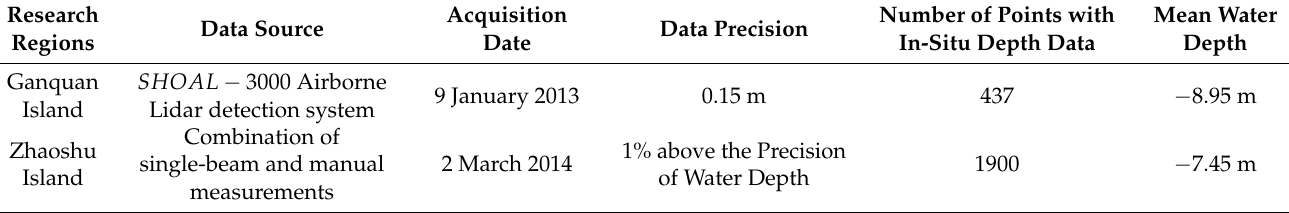
Table 2. Information on the actual water depth of the two research